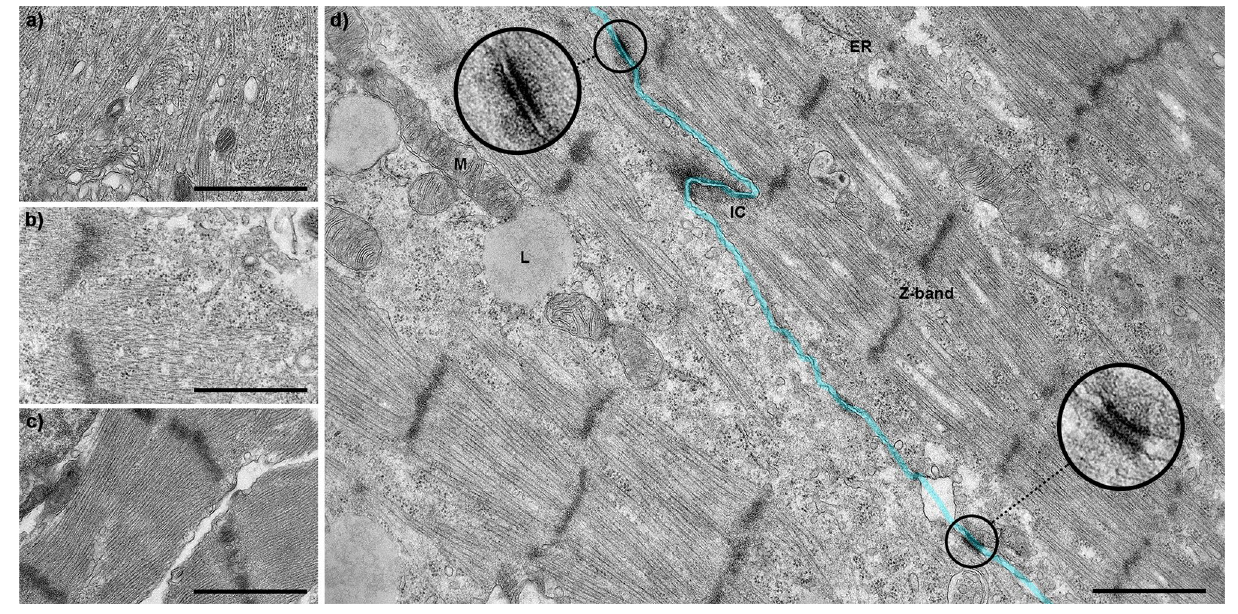
Figure 3. Transmission electron microscopy showed improved structural maturity of cardiomyocytes in cardiac tissue model compared to cardiomyocyte monoculture. Immature cardiomyocytes in ( a ) the cardiomyocyte monoculture and ( b ) the cardiac tissue model contain unorganized myofibrils on day 1. ( c ) Monocultured cardiomyocytes have developed organized sarcomeres by day 7. ( d ) Two adjacent cardiomyocytes with highly developed and aligned sarcomeres show intercalated discs (IC) and desmosome connections (circled and magnified) in the cardiac tissue model on day 6. Light blue indicates the line between two adjacent cardiomyocytes. ER = endoplasmic reticulum, M = mitochondria, L = lipid droplet. Scale bar 1 µm. The experiment was performed with one well from CM day 1, two parallel wells from CTM day 1, two parallel wells from CM day 7, and two parallel wells from CTM day